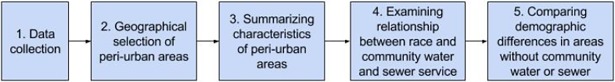
Main steps of the research methods.